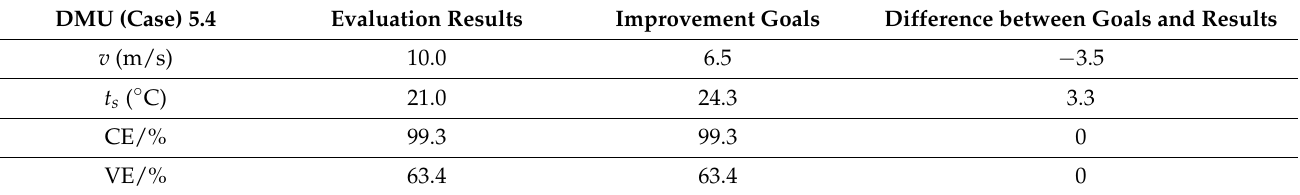
Table 8. Optimization strategies for Case 5.4.